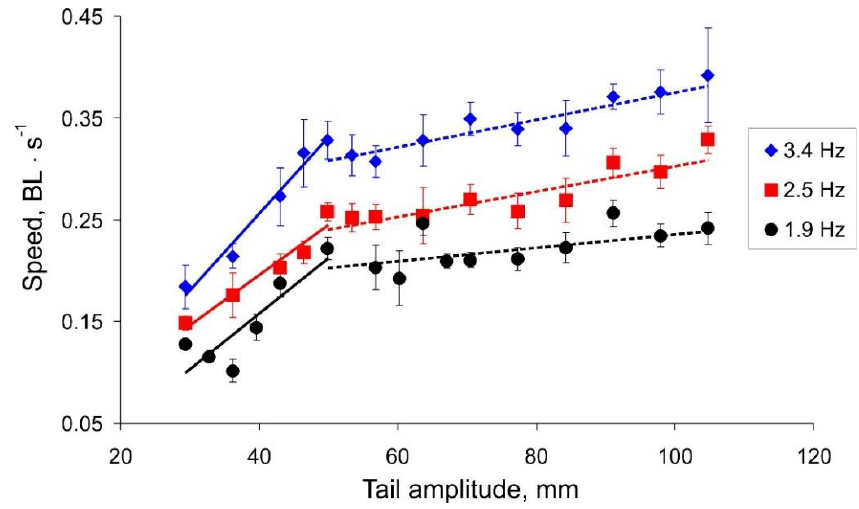
Figure 6. The robot speed vs. the tail amplitude in three modes of the tail beat frequency.